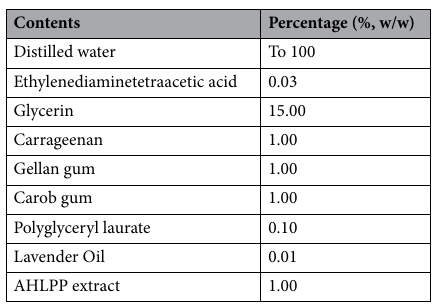
Table 2. Composition of the hydrogel polymer with the mixture of plant extracts from agrimonia, houttuynia, licorice, peony, and phellodendron (AHLPP)